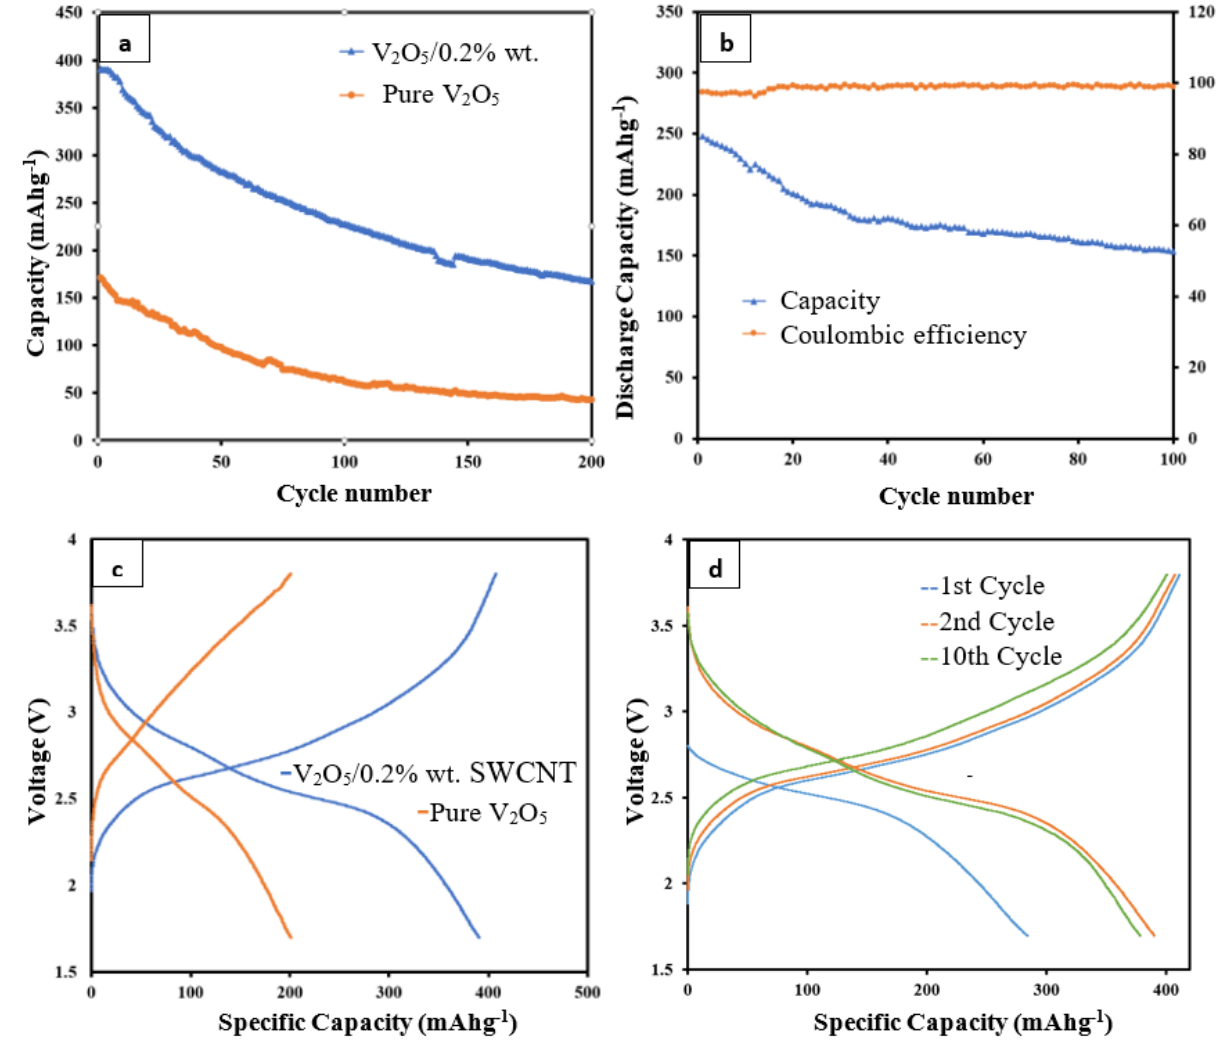
Figure 7. Electrochemical properties analysis. ( a ) Specific capacity of V 2 O 5 ‐ SWCNT and pure V 2 O 5 at a 0.1 C rate. ( b ) Cycle life with coulombic efficiency of V 2 O 5 ‐ SWCNT at a 1 C rate. ( c ) Charge vs. discharge curves of coin cells made of pristine V 2 O 5 and V 2 O 5 –SWCNT, respectively. ( d ) Charge– discharge curves of V 2 O 5 ‐ SWCNT cells at 0.1 C rate for 1st, 2nd and 10th cycle.